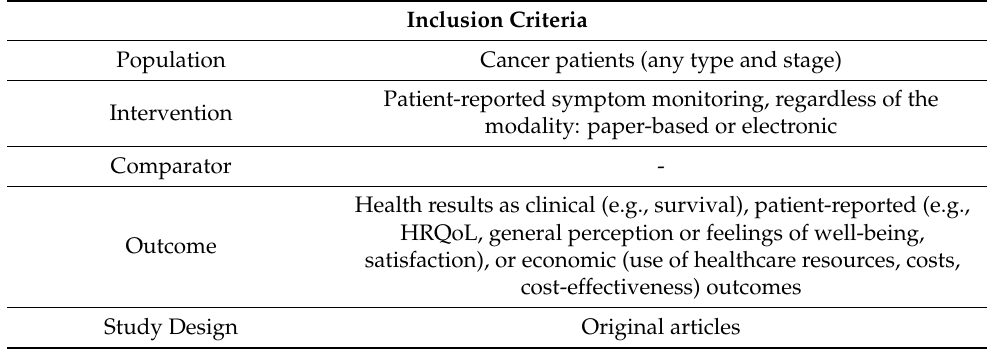
Table 1. Eligibility criteria defined by PICOS.